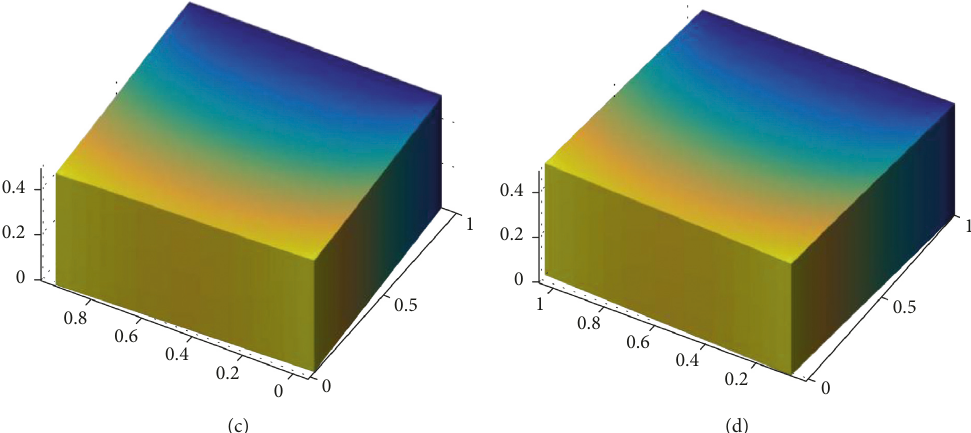
Figure 4: Mode shapes of the elastically supported plate elastically restrained in the z direction: (a) k (d) k v � 10 16 .